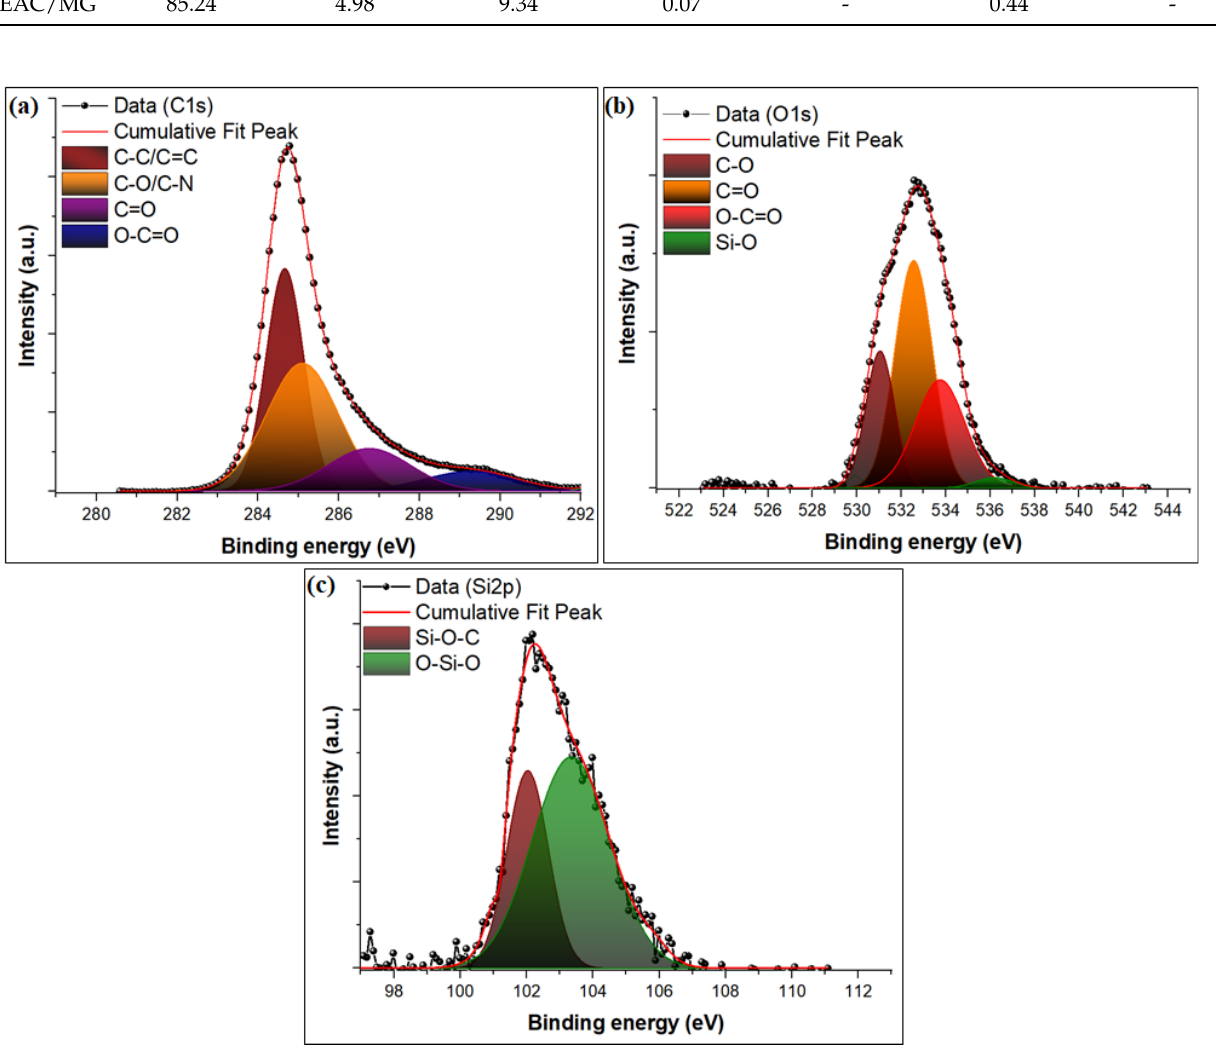
Figure 3. Deconvoluted high-resolution XPS spectra of C1s ( a ), O1s ( b ), and Si2p ( c ) for the SBPEAC